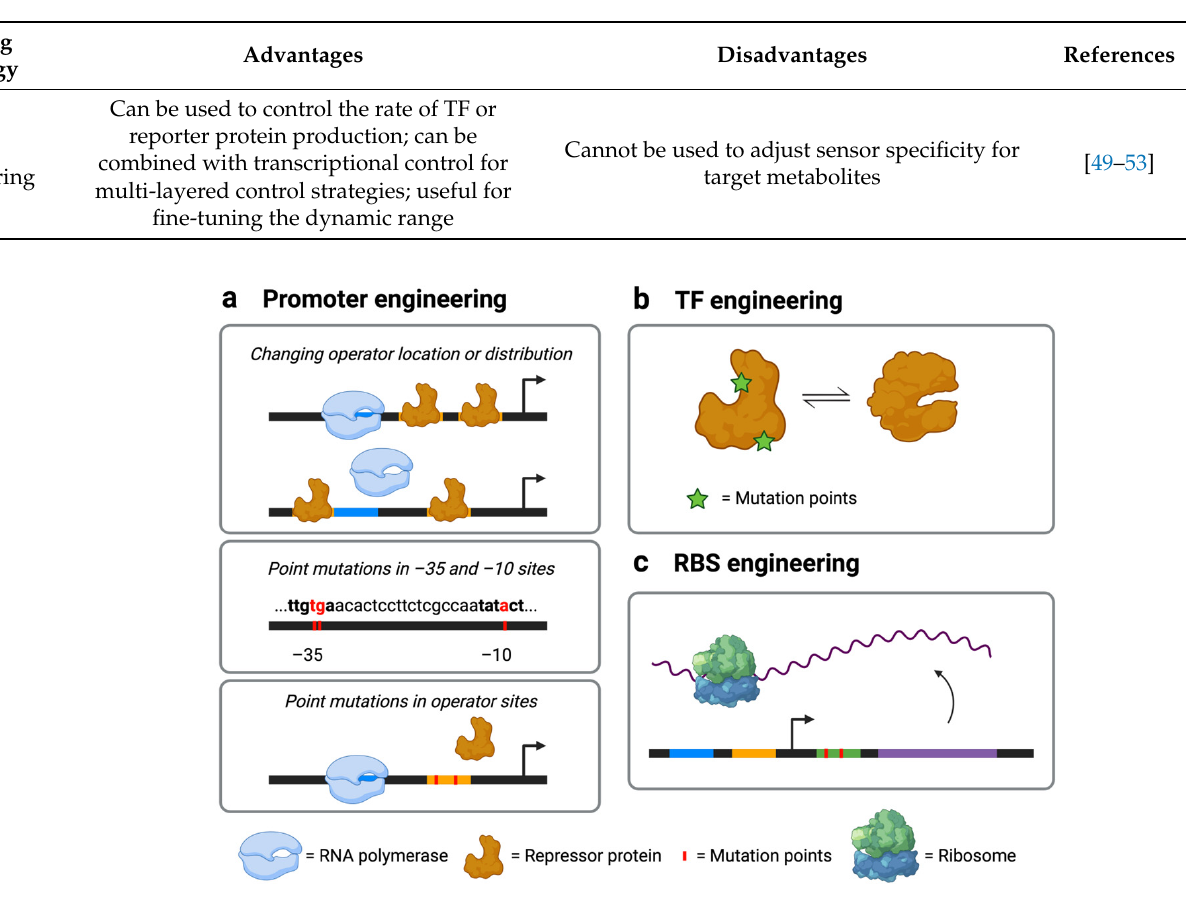
Figure 2. Tuning strategies for biosensors. ( a ) Promoter engineering through changing the number and location of operator sites, mutating the − 35 or − 10 region of the promoter, or mutating the transcription factor (TF)-binding operator sites (the black bar represents the DNA sequence; the blue segment represents the RNA polymerase binding site; the orange segment represents the TF-binding site; additional icons are defined in the Figure); ( b ) TF engineering via mutations to the ligand-binding pocket or the DNA-binding domain; ( c ) ribosome-binding site (RBS) engineering (the green segment represents the RBS sequence; the purple segment represents the gene of interest; additional icons are defined in the Figure). Table 1. Advantages and disadvantages of tuning strategies for biosensors.